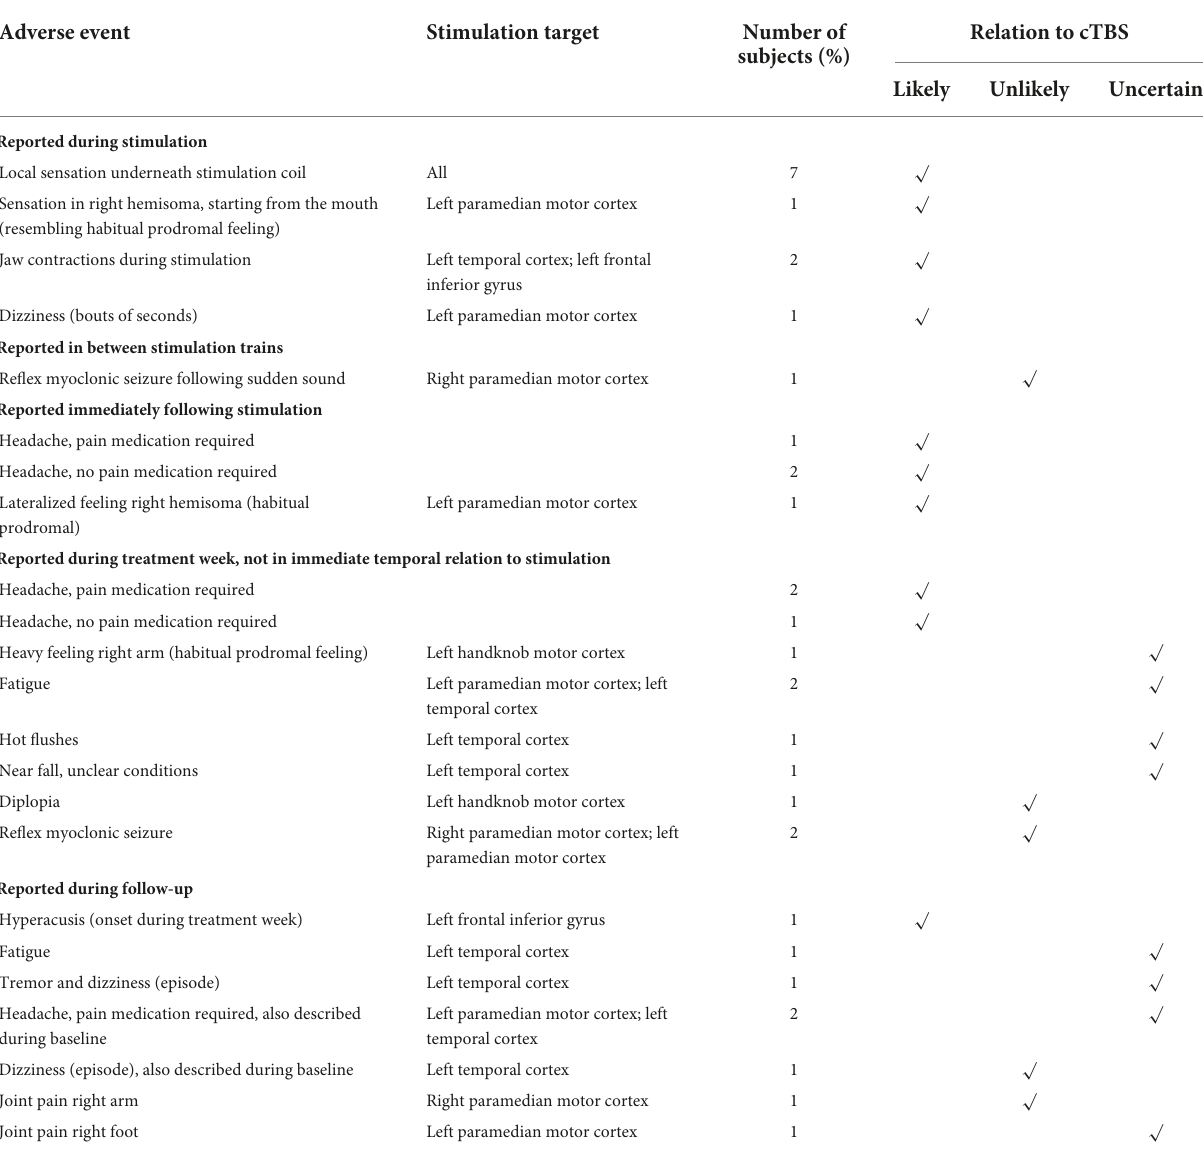
TABLE 2 Adverse events reported during treatment week and follow-up. Adverse